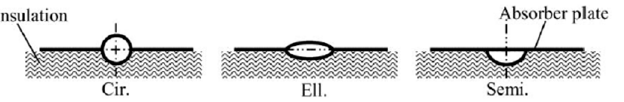
Figure 2. Cross-sectional views of the prototype wickless heat pipe flat plate solar collector [10].